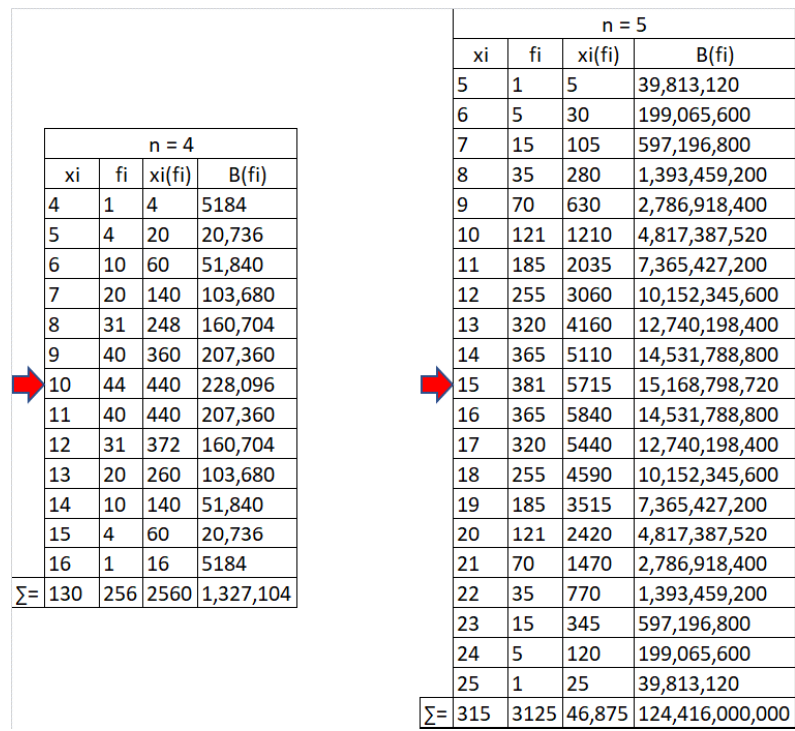
Figure A1. Row sum totals in Borda distribution for n = 4, 5.